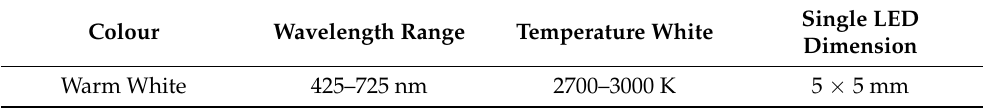
Table 3. Characteristics of